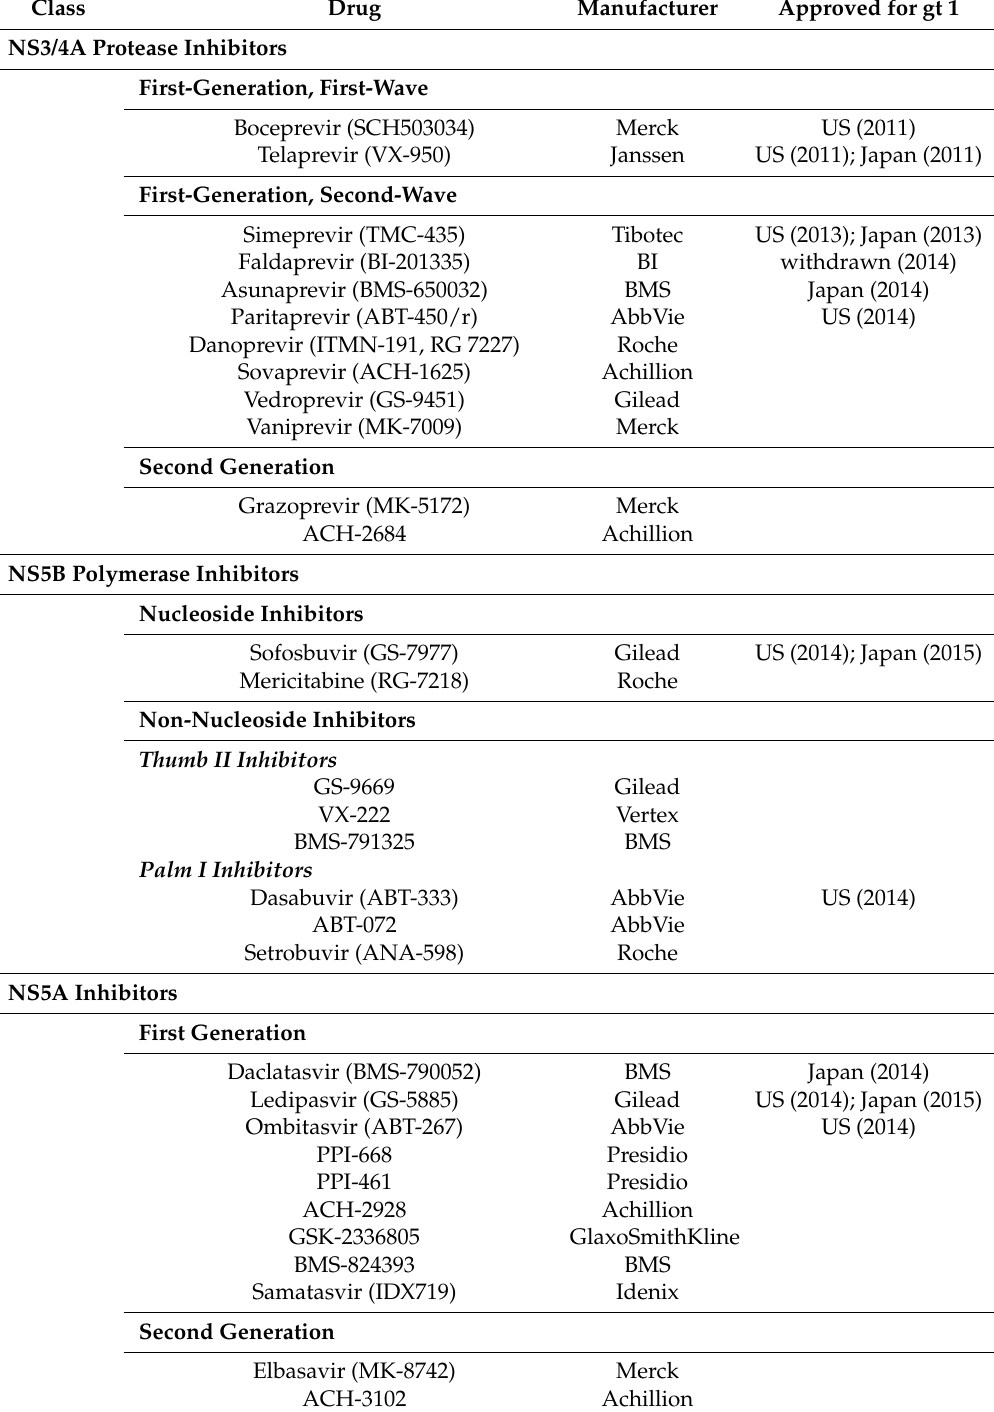
Table 1. Characteristics and resistance profiles of selected direct acting antiviral agents in the United States and